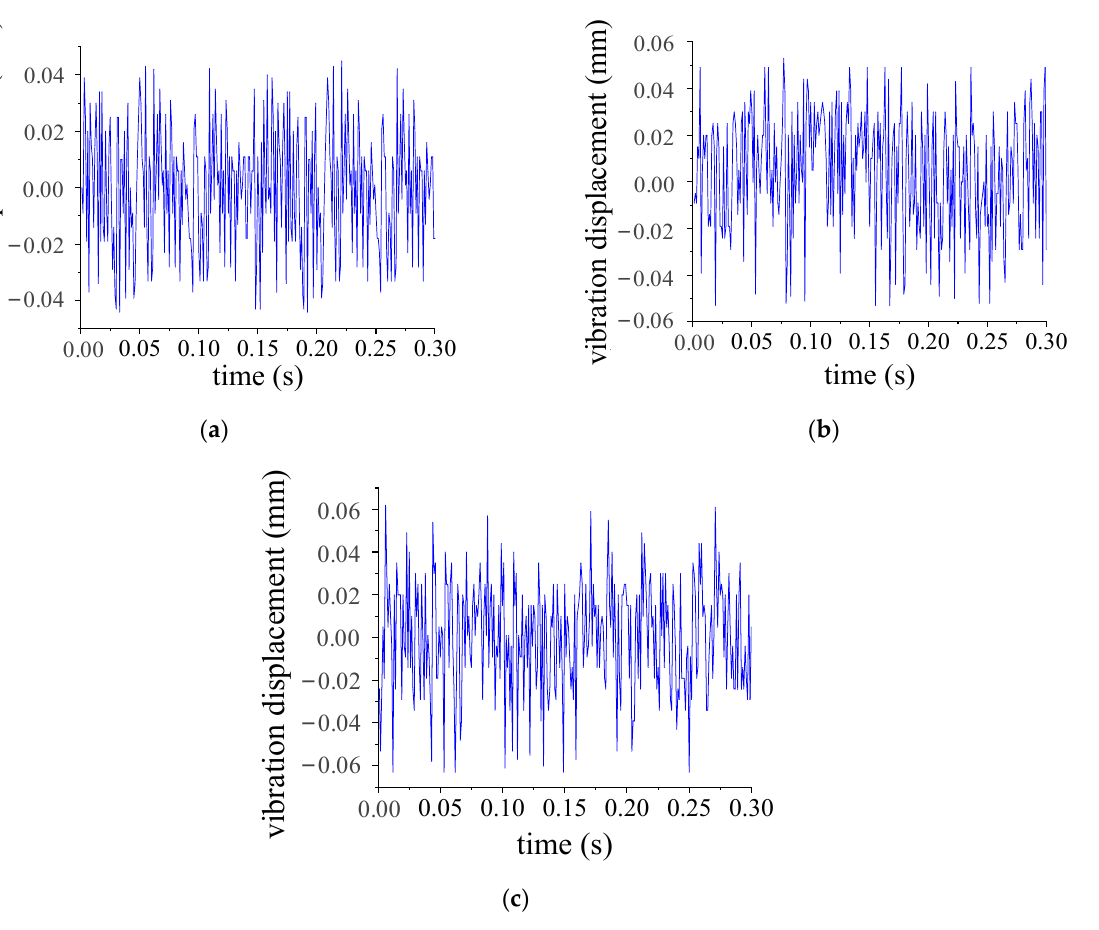
Figure 15. The vibration displacement of the carrier in the third stage. ( a ) Vibration displacement at 50% load; ( b ) vibration displacement at 100% load; ( c ) vibration displacement at 150% load.